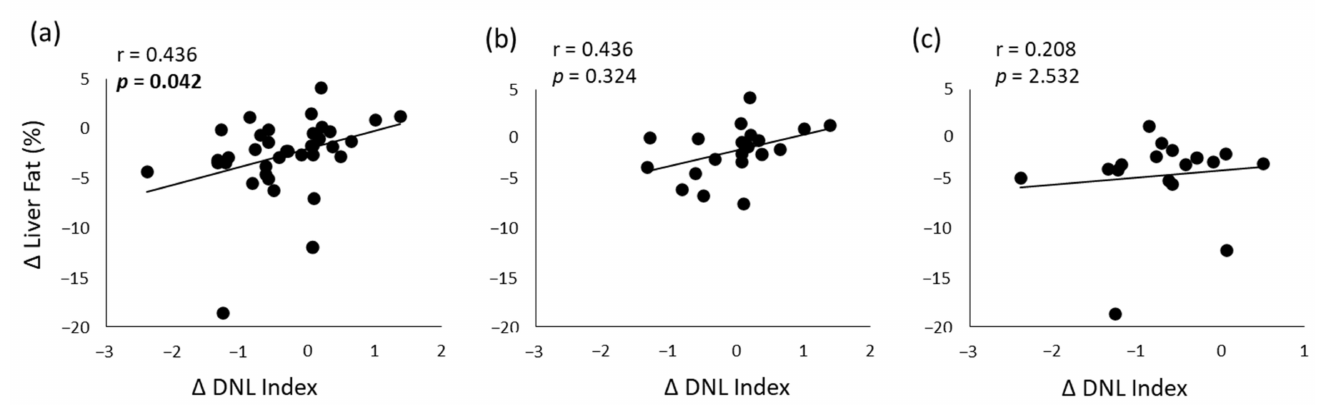
Figure 2. Relationships between changes ( ∆ : 8th week minus baseline) in the DNL index and changes in liver fat in the whole population ( n = 37) ( a ), in the MUFA group ( n = 20) ( b ) and in the multifactorial group ( n = 17) ( c ). Spearman’s correlation